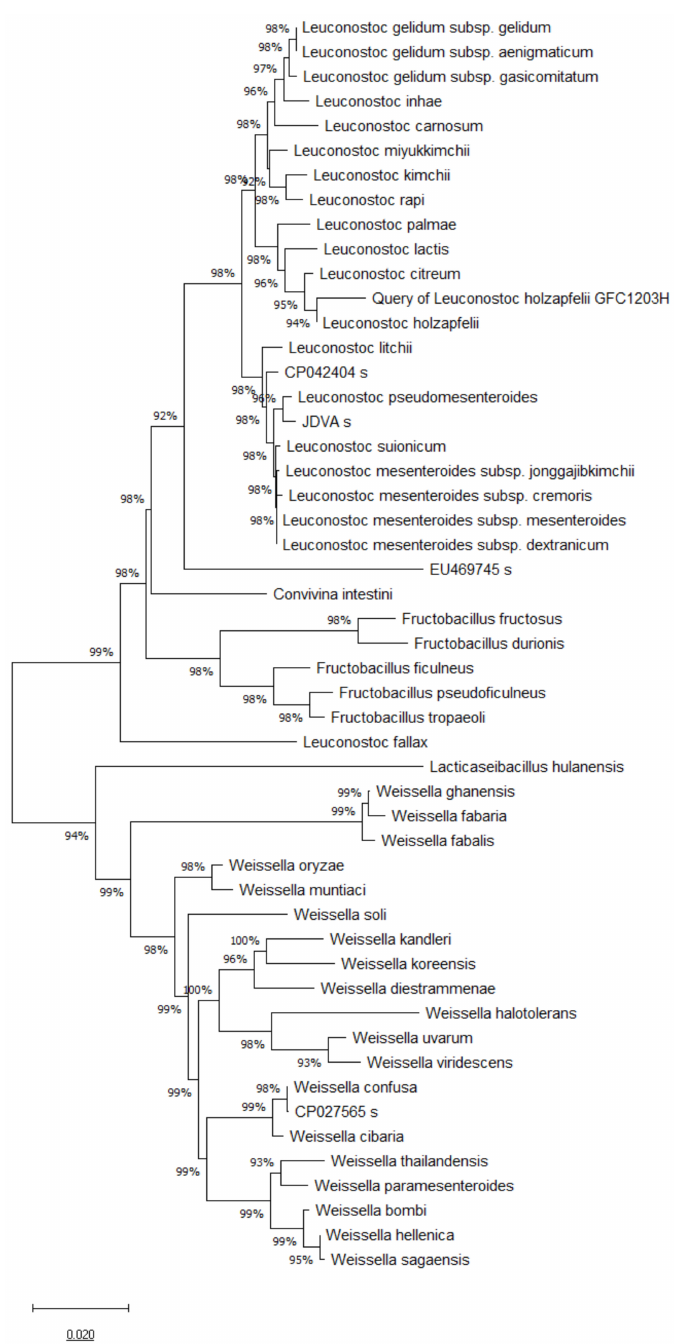
Figure 1. Phylogenetic tree based on 16S rRNA gene sequences of Leuconostoc holzapfelii isolated from the human